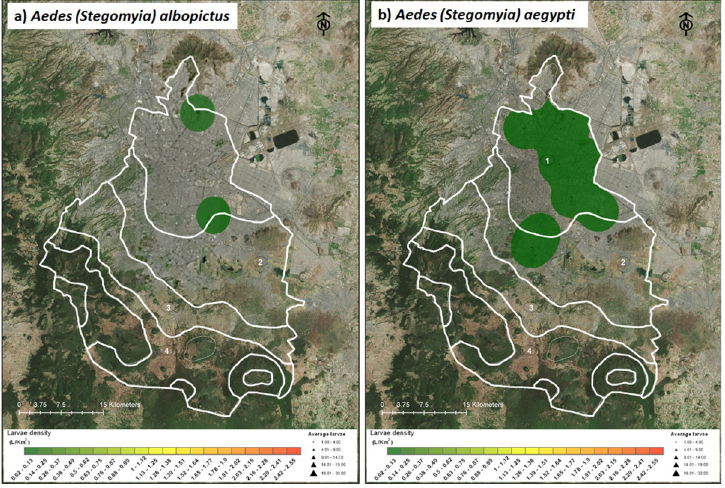
Fig 3. Distribution of Aedes aegypti and Aedes albopictus of Mexico City eggs from ovitraps collected in the present